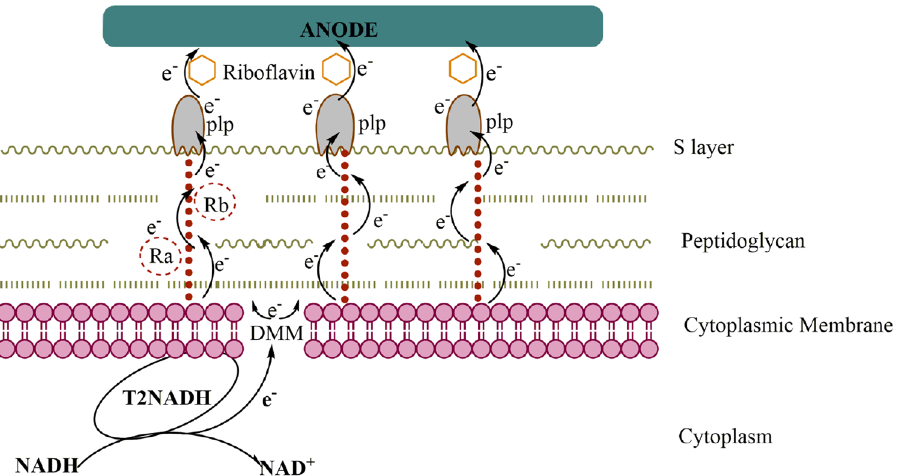
Figure 5. Schematic of putative Mediated electron transfer (MET) model in Geobacillus sp. strain WSUCF1. T2NADH, Type II NADH Dehydrogenase; DMM, Dimethyl Menaquinone Pathway; Ra and Rb, Putative redox active protein embedded in teichoic acids; plp, Outer membrane redox active phermone